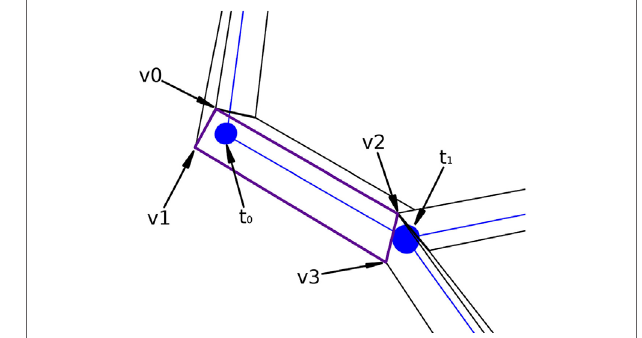
FIGURe 7 | Correspondence between the four lateral quad vertices and their two corresponding morphological tracing